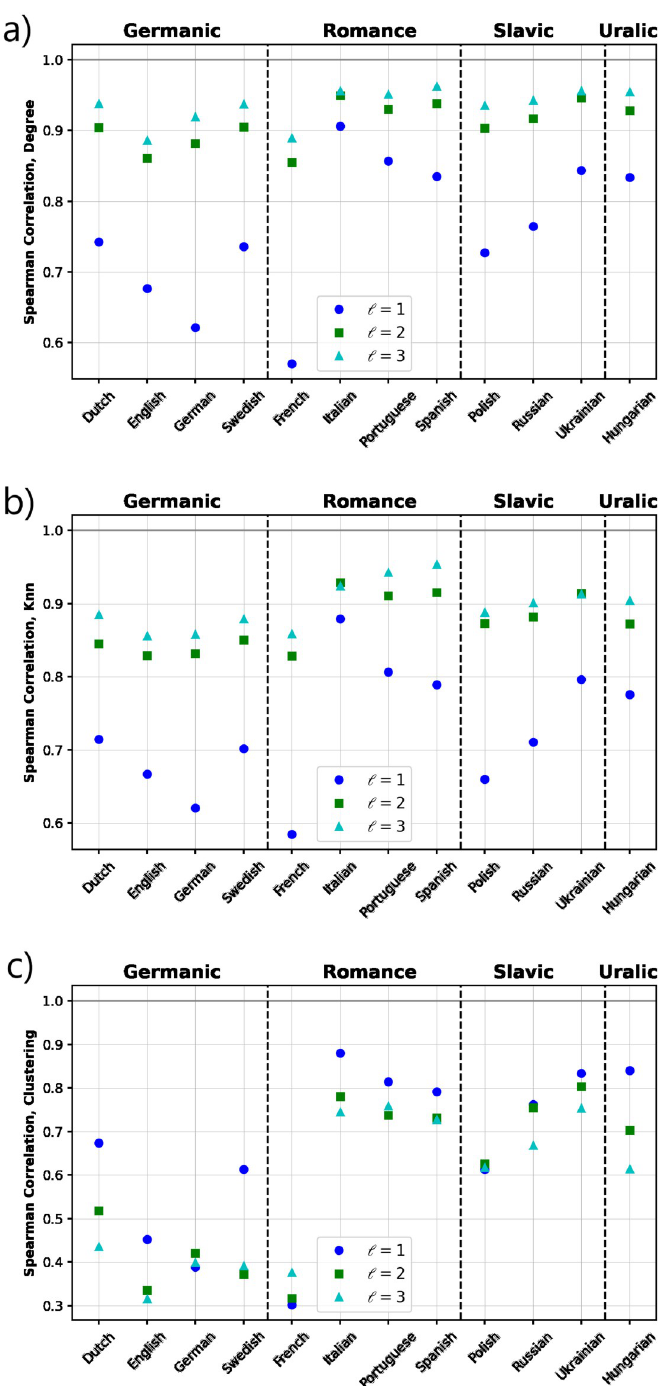
Fig 5. Correlations between some structural properties of the orthographic and phonological networks. We show the Spearman-rank correlation coefficient for (a) degree, (b) average nearest neighbor degree and (c) average clustering. For most of the languages, similar levels of positive correlations are observed for the three properties, except the cases of the Germanic family and French for which the clustering is noticeable lower compared to the rest of